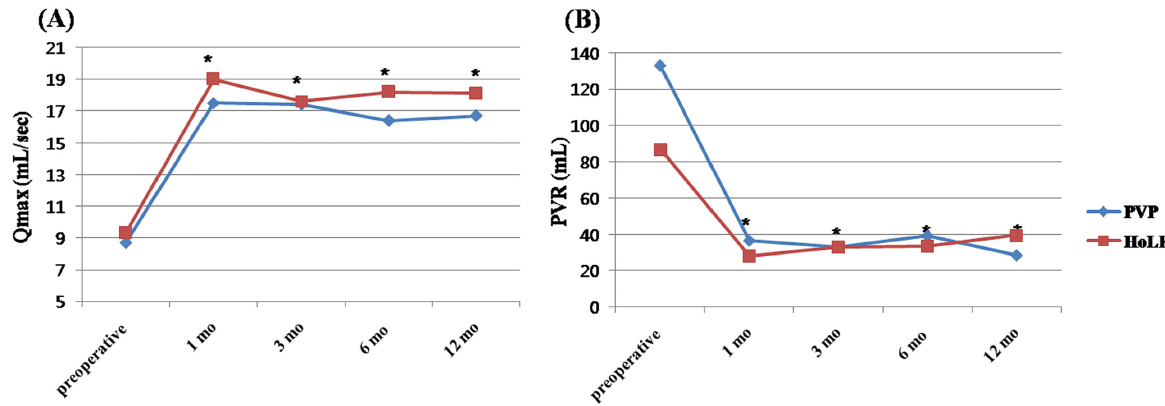
Fig 1. Changes in Qmax (A) and PVR (B) in the PVP and HoLEP groups. Qmax, urinary peak flow rate; PVR, post-voiding residual urine; PVP, photoselective vaporization of the prostate; HoLEP, holmium laser enucleation of the prostate. * P < 0.05; compared with preoperative